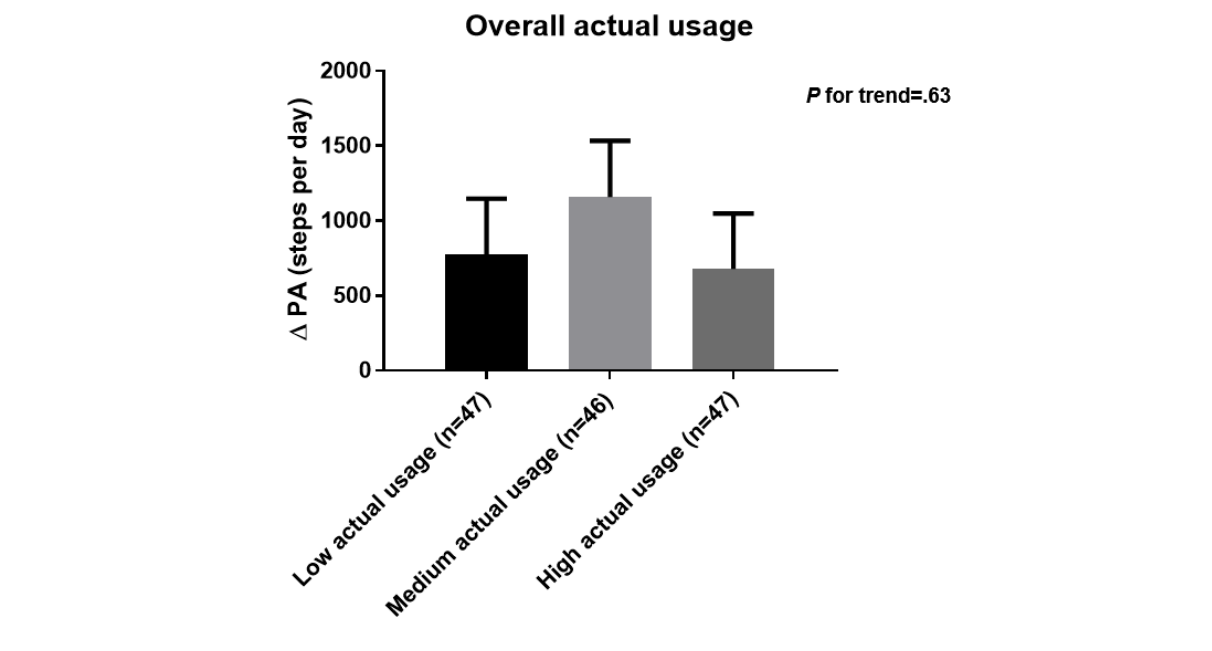
Figure 6. Change in physical activity (PA; mean [SE] across groups of patients according to overall actual usage score; adjusted for age, baseline functional exercise capacity, baseline forced expiratory volume in 1 second, baseline symptom score and number of acute exacerbations in the previous 12 months. P value (P for trend) indicates difference in intervention effect between patients divided based on the total actual usage score, after adjusting for the covariates. Data are based on Actigraph measurements and include 140 patients. Unadjusted scores were mean(SD) +777 (SD 2767) steps